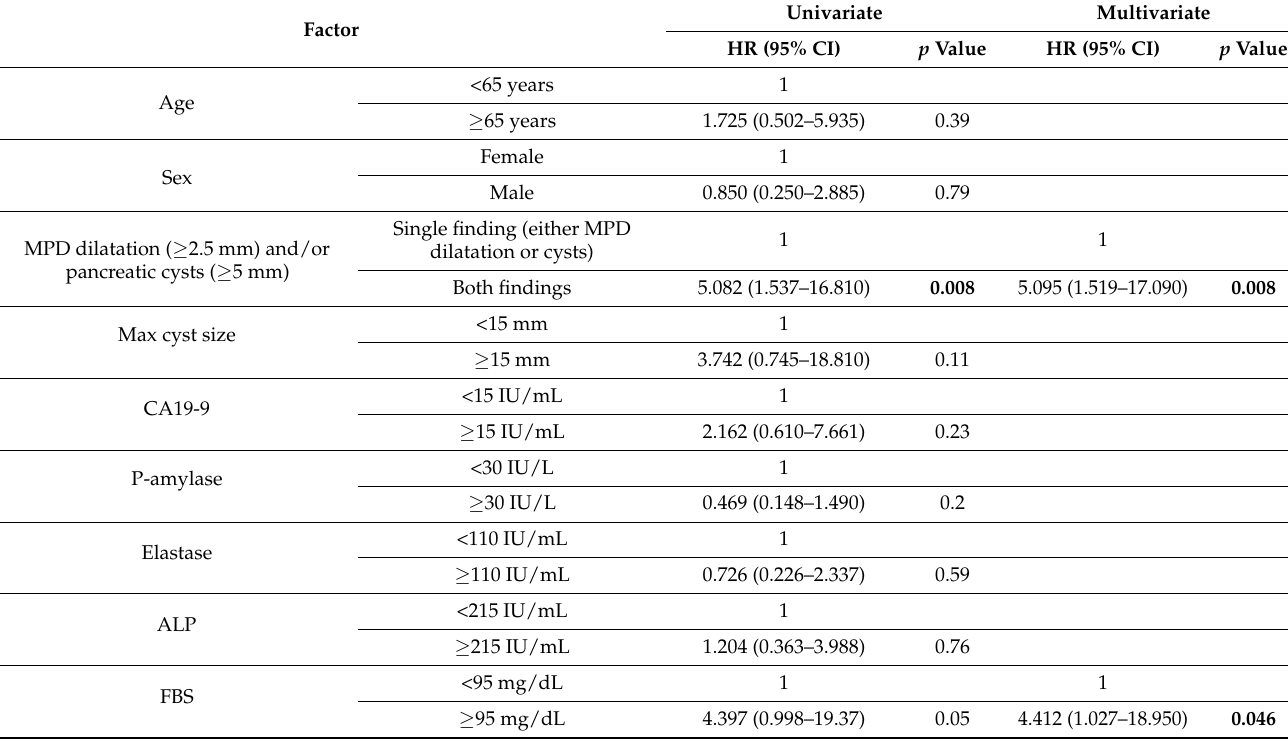
Table 3. Univariate and multivariate analyses of factors associated with neoplastic progression in terms of baseline characteristics at initial